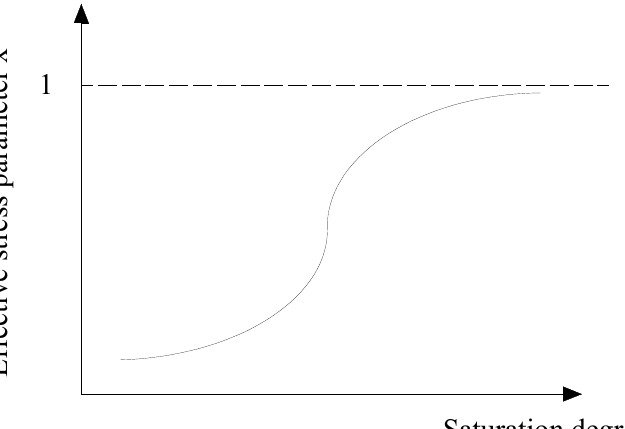
Figure 2. Soil–water characteristic curve.